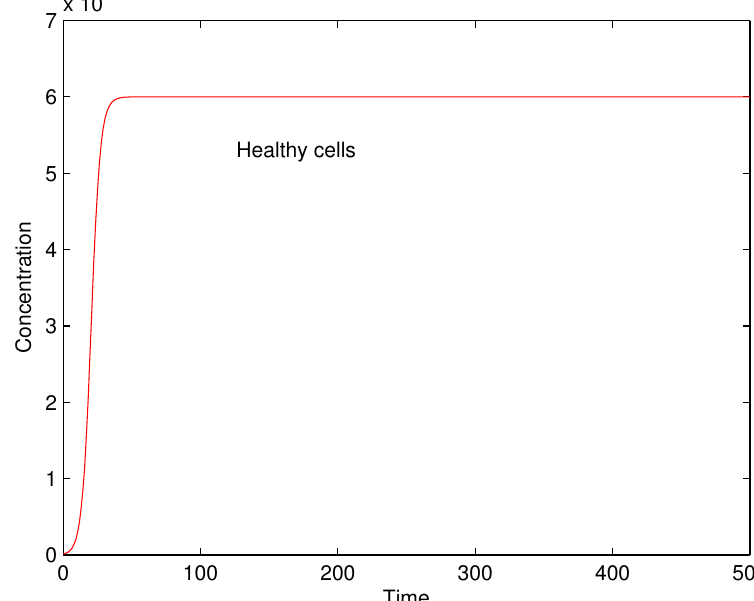
Figure 1. Concentrations of healthy cells for n v ( 0 ) = 0, f h ( 0,0 ) = 0 and p id = 0.